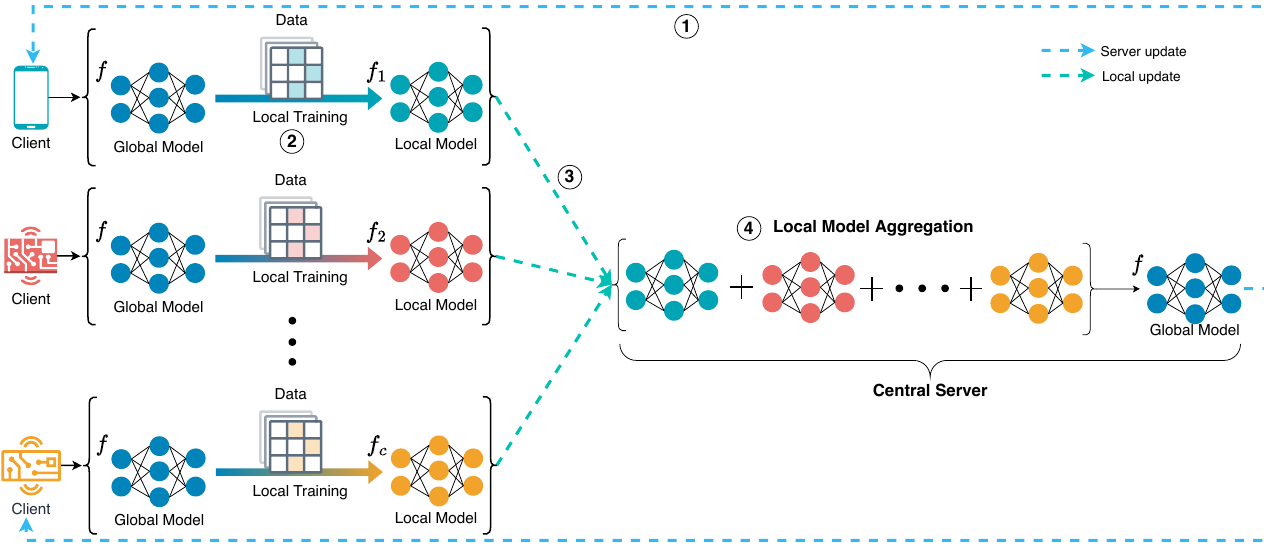
Figure 1. Vanilla Federated Learning